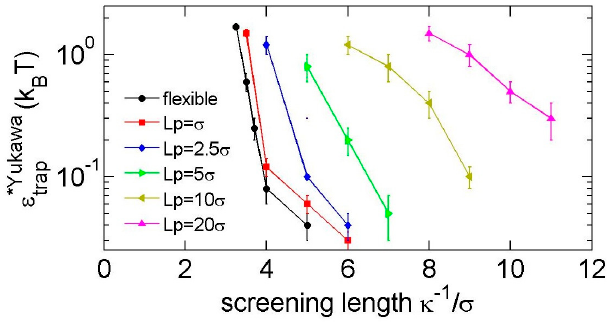
Figure 8. The minimal strengths of Yukawa repulsions for trapping a trefoil knot.